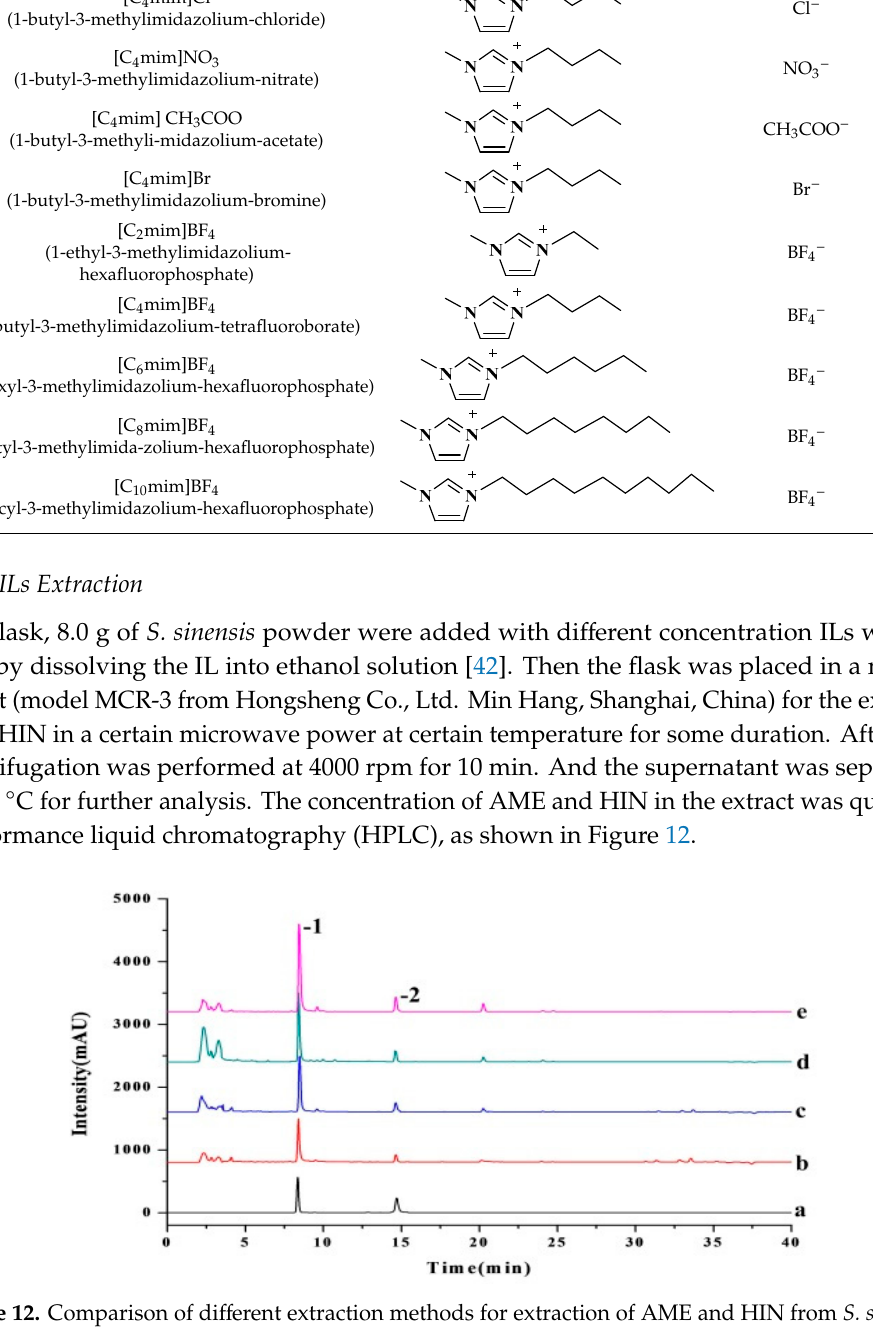
Table 5. Chemical structures of ionic liquids.